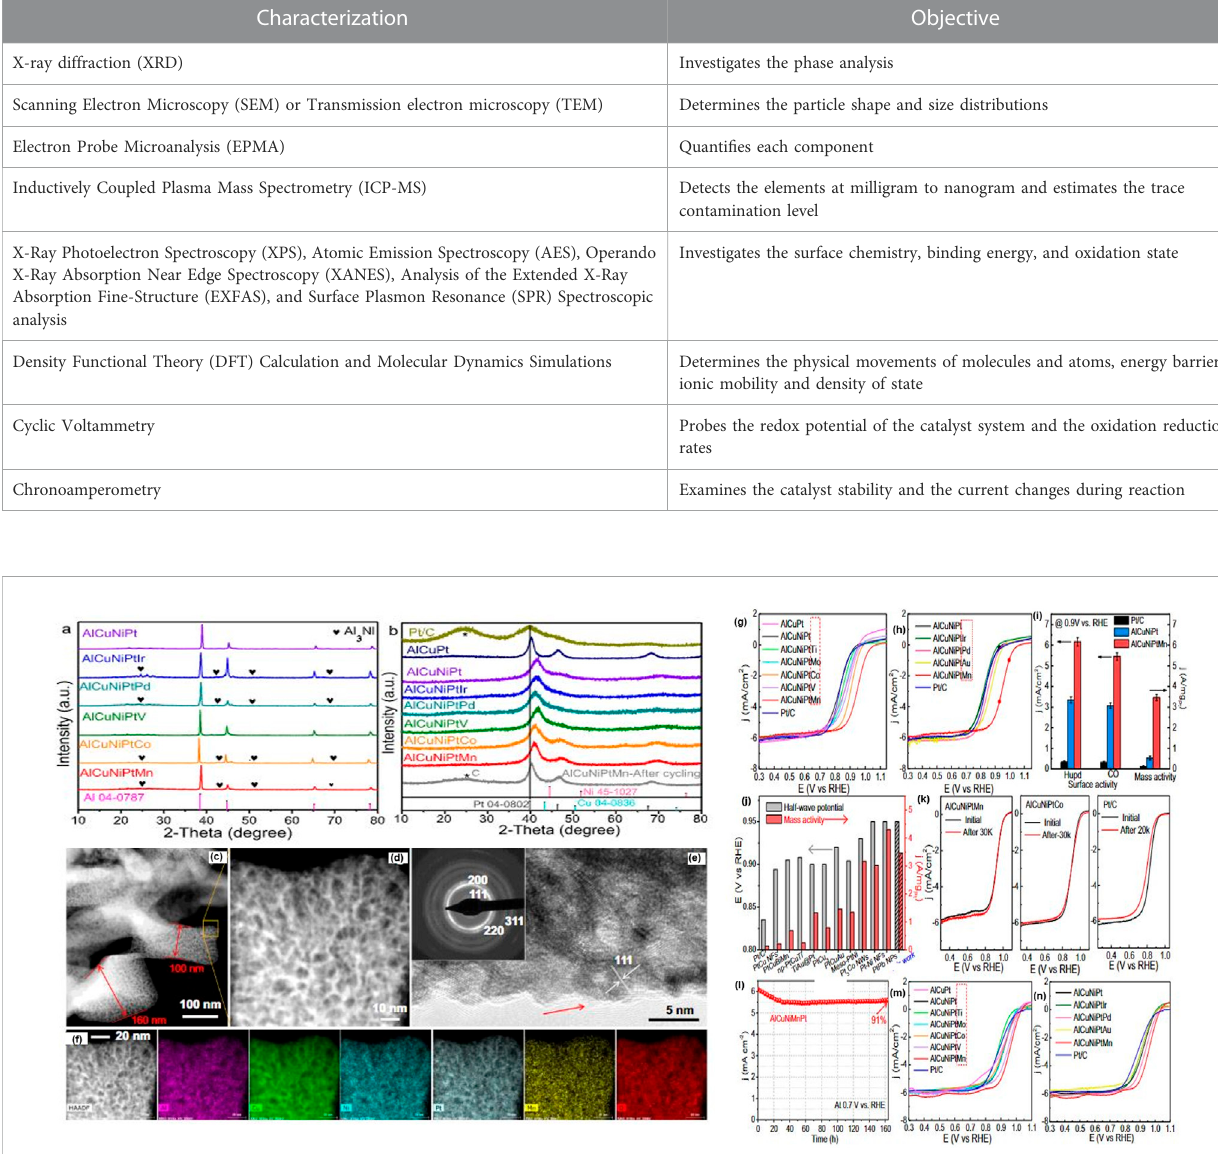
FIGURE 5 (A,B) XRDgraphs oftheprecursorHE-NPsbeforeand afteretching in0.5 MNaoHsolution (C – F) SEM andTEMMicrographsofthenp-AlCuNiPtMn HE-NP. (G – N) Oxygen Polarization curves of the HE-NPs (Li S. et al.,